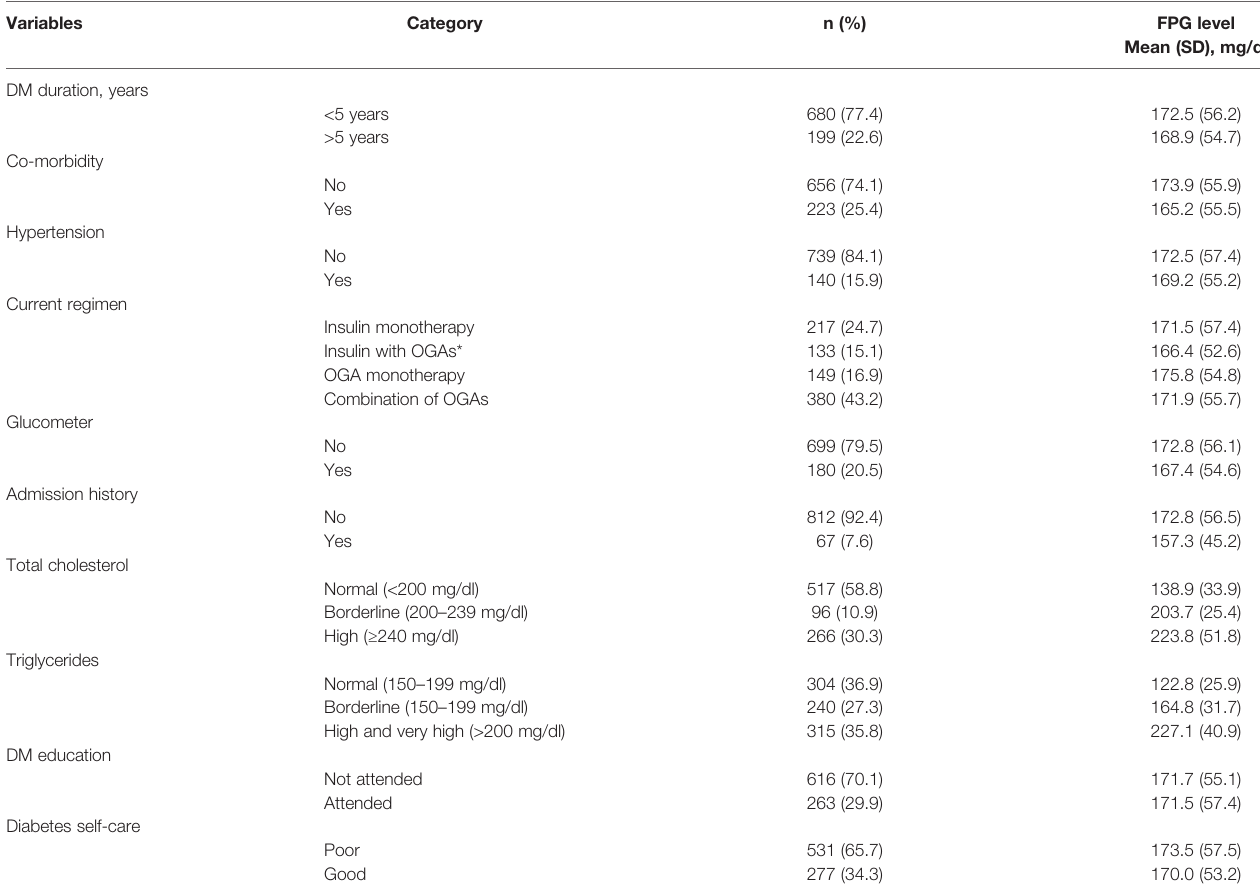
TABLE 2 | Clinical characteristics by mean FPG level of the patients with T2D in Eastern Ethiopia, 2020/2021 (n = 879). Variables